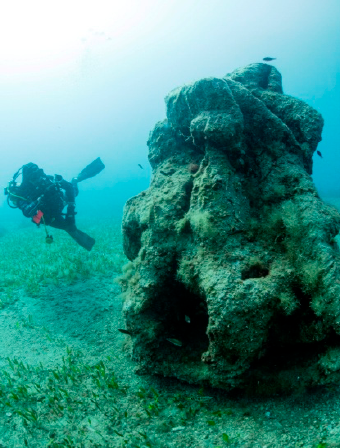
Figure 1. View of the seabed in the area of experimental installation of an artificial naturoid reef of HCMR in the Underwater Biotechnology Park of Crete.